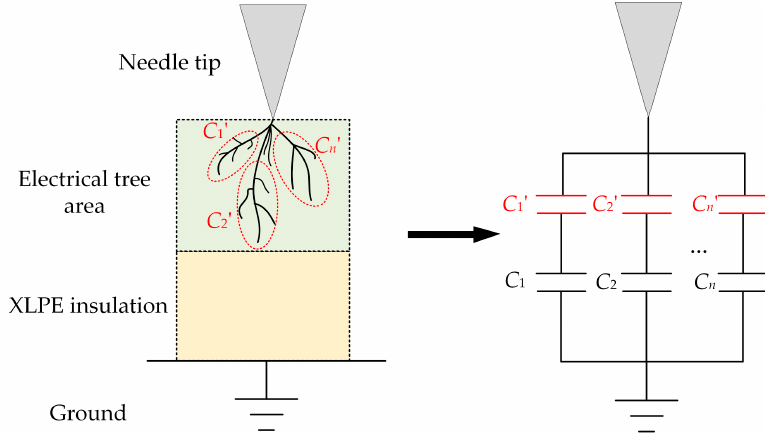
Figure 10. The model of distributed parameters during the growth of electrical trees .